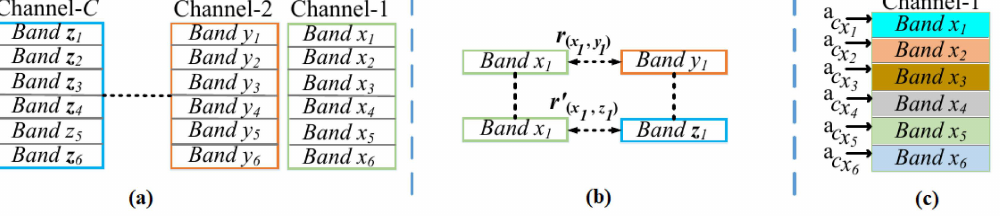
Figure 6. Novel channel attention learning for individual parts. ( a ) Dividing C channels into six bands; ( b ) Learning relations among bands; ( c ) Channel attention weight a’ c